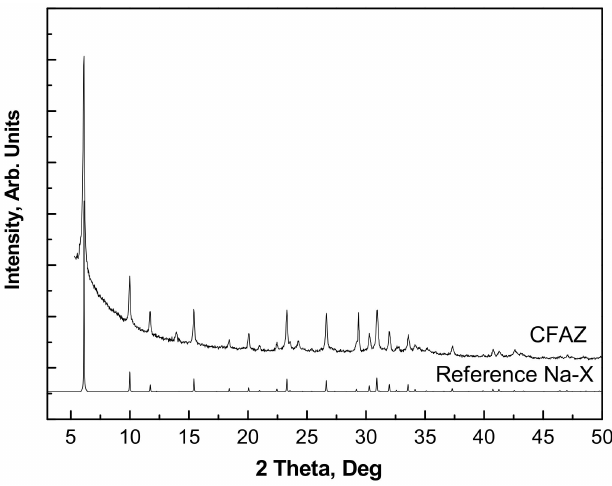
Figure 2. XRD studies of CFAZ. Morphological studies revealed fine individual submicron crystallites of the zeolite product due to the applied ultrasonic homogenization of the reaction mixtures and frag- mentation of CFA particles. SEM micrographs in different magnifications are presented in Figure